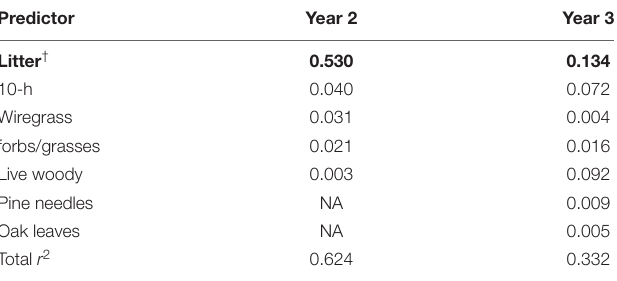
TABLE 4 | Relative importance (non-normalized contribution to multiple-r 2 in linear regression) of energy in surface fuel types in 1 m 2 plots as predictors of FRED in prescribed fires in longleaf pine woodlands in southwest Georgia, United States (relative importance ≥ 0.10 indicated by bold font).